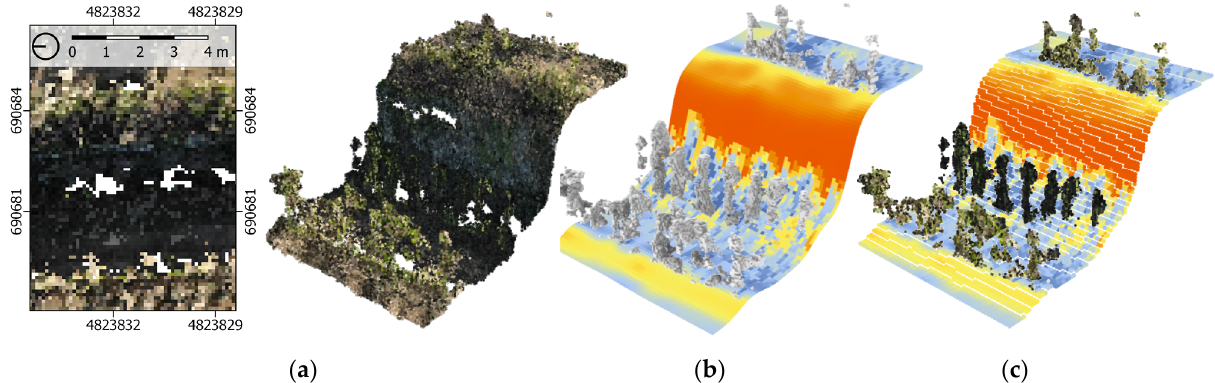
Figure 4. Fully three-dimensional solar radiation simulation performed in the Grasshopper plug-in Ladybug Tools [43]. The values of the total solar radiation were collected from the local meteorological station. ( a ) Representative fragment of the vineyard was chosen. ( b ) Custom mesh representations of the CVM was constructed in Grasshopper. ( c ) The outcomes of the analysis for the ground cells were fed back to the CVM.